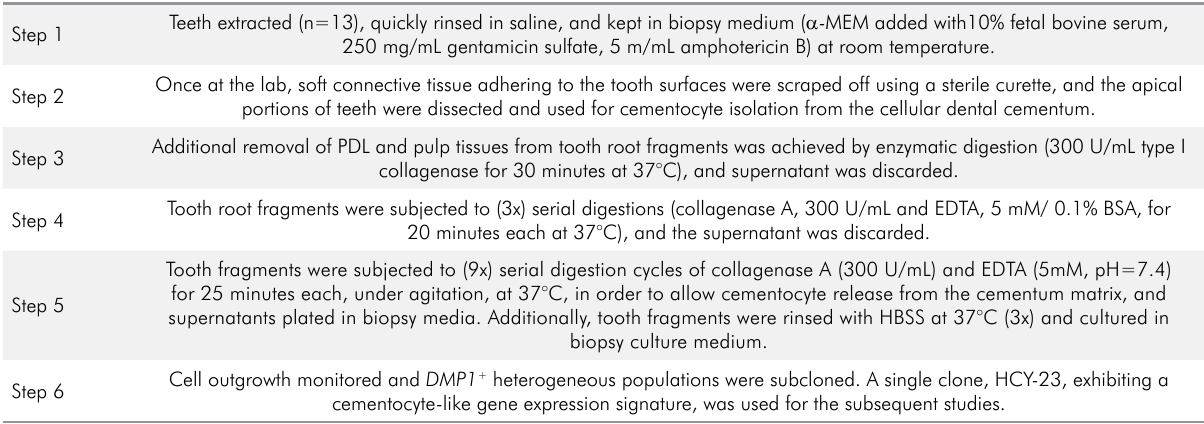
Table 1. Description of the procedures used for isolating a human-derived cementocyte-like cell line. Step 1